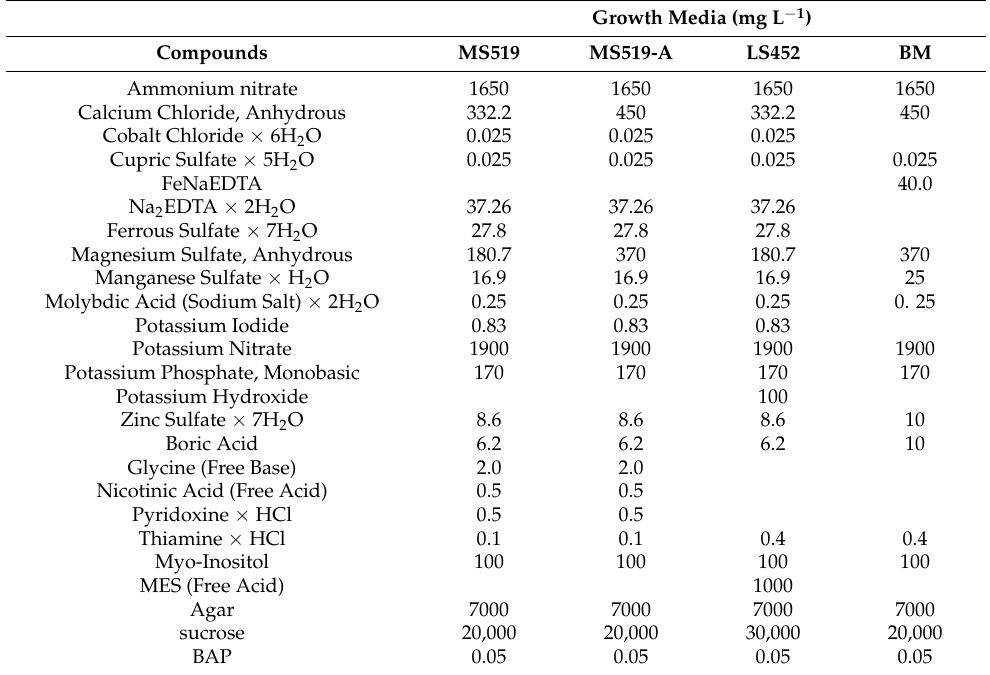
Figure 1. ( a ) Offshoot from the field cleaned from residual soil; ( b ) reduction of the size of the offshoot; ( c ) shoot tips ready for surface sterilization. Table 1. Composition of growth media tested for shoot multiplication of ‘Troianella’ landrace artichoke.